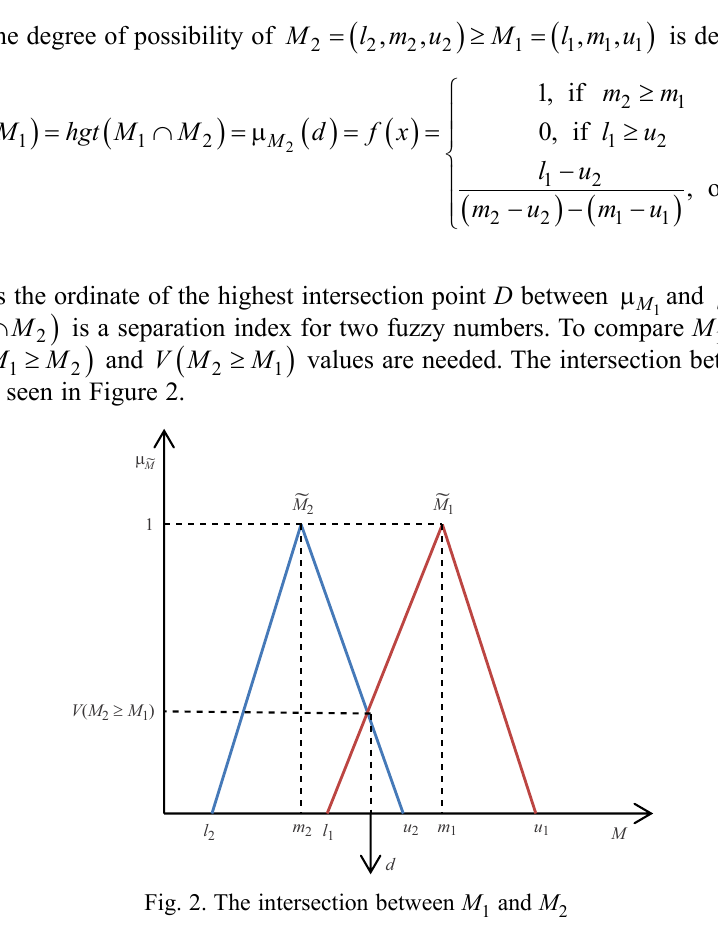
Fig. 2. The intersection between M